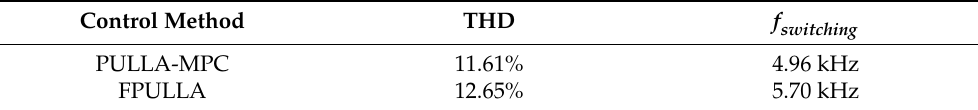
Figure 7. Test 1. Steady-state performance of FPULLA-MPC (left) and PULLA-MPC (right). From top to bottom: ( a ) motor speed, ( b ) 𝑑 - 𝑞 currents, ( c ) 𝑥 - 𝑦 currents, ( d ) zoom of the 𝑥 - 𝑦 currents, and ( e ) set 1 of phase currents. Table 2. Total harmonic distortion and switching frequency in Test 1.